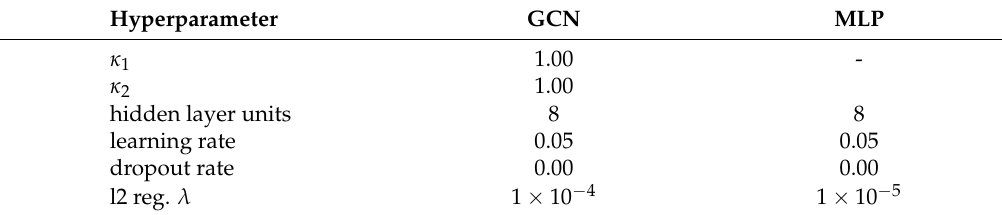
Table 10. List of hyperparameters in the neural networks.